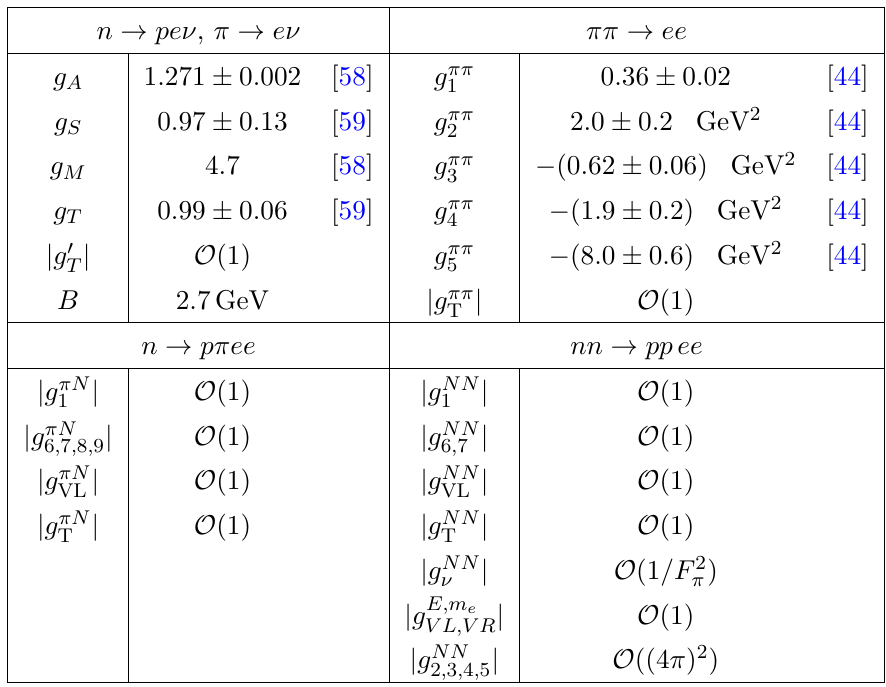
Table 1 . The low-energy constants relevant for the dim-3, dim-6, dim-7 and dim-9